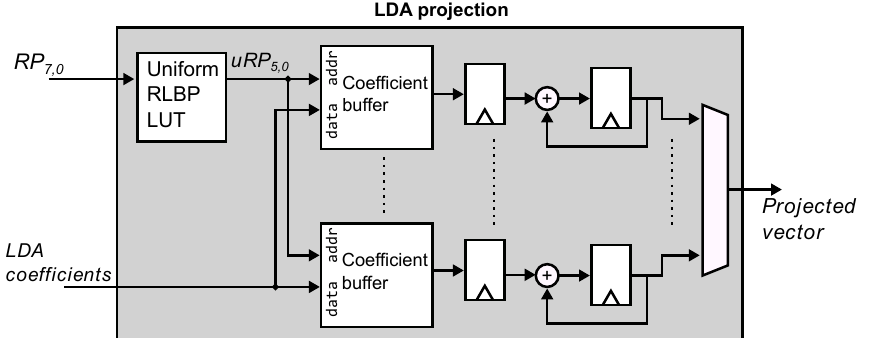
Figure 11. Architecture of the LDA projection module. The module transforms the 8-bit RLBP into a 6-bit uniform RLBP (uRP). For each uRP value received, the module accumulates the value of its corresponding LDA coefficient, thus performing histogram computation and LDA projection in a single